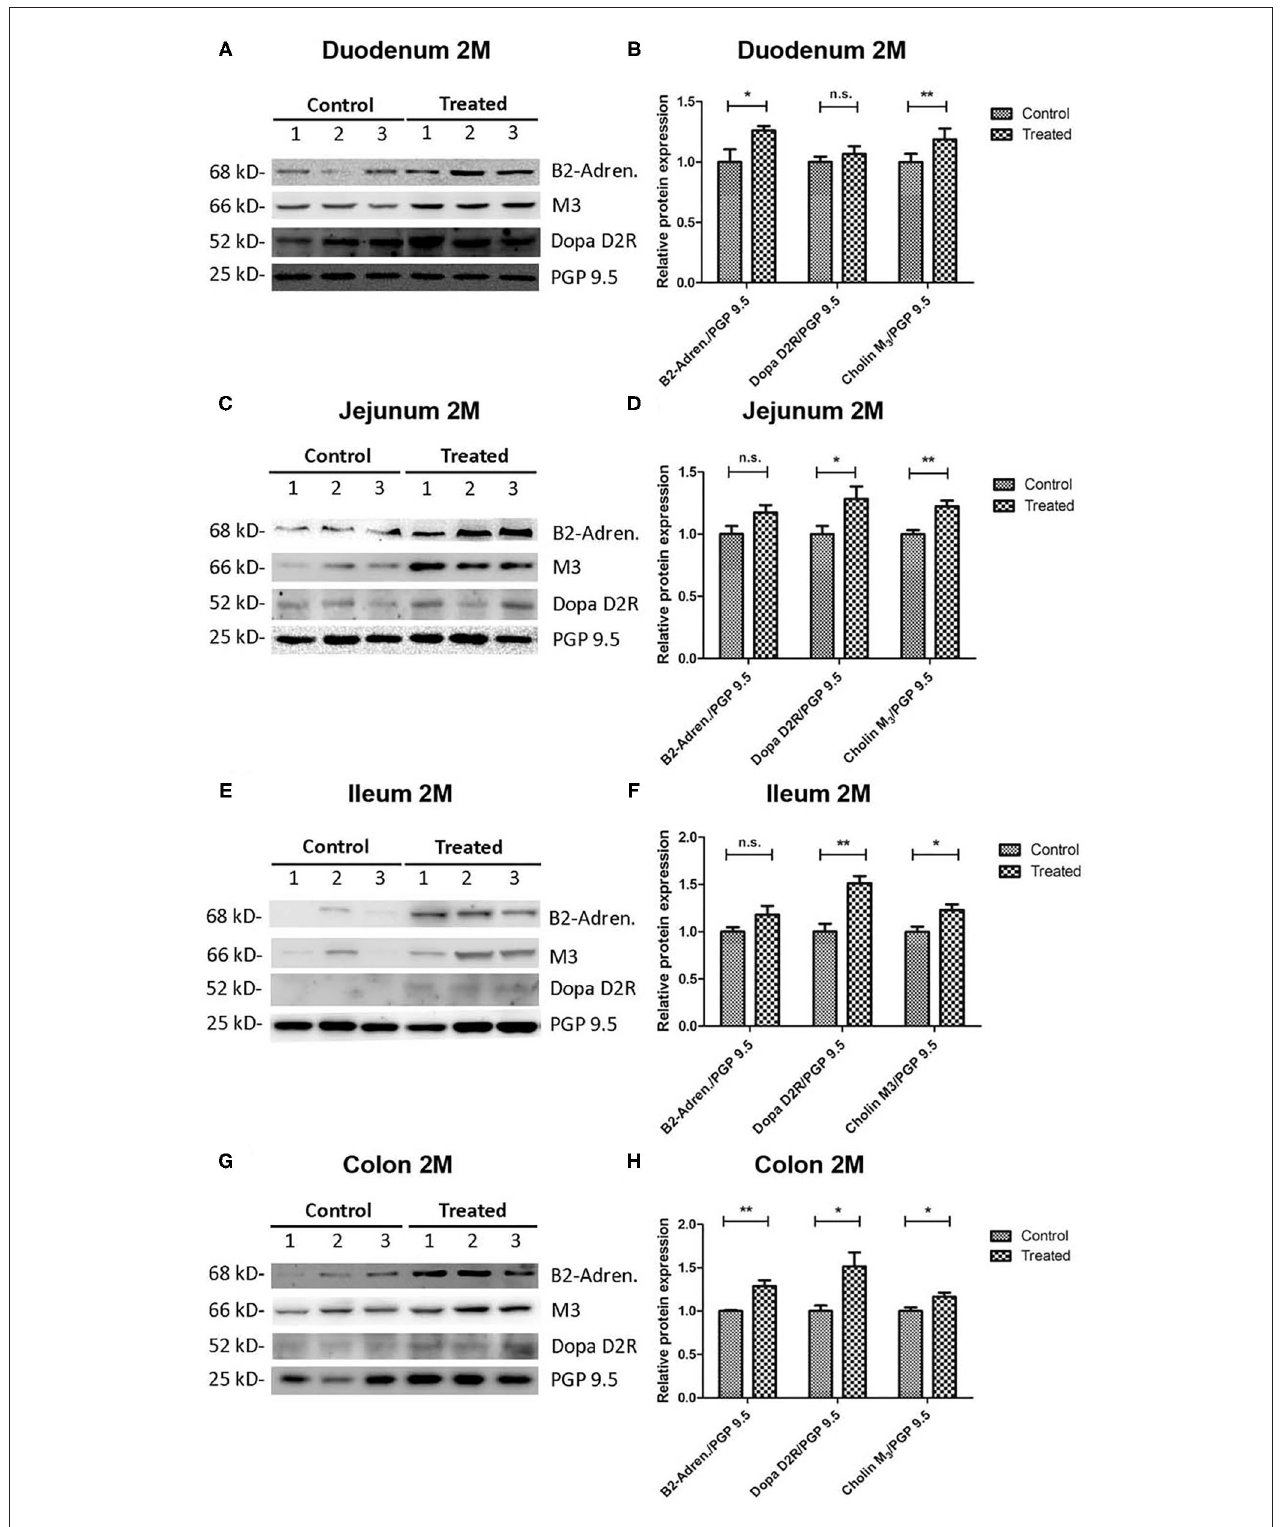
FIGURE 9 | Two-Month rotenone exposure induces an up regulation of the adrenergic (ß2-subunit), cholinergic (M3-muscarinic), and dopaminergic (D2) receptors in the gut. Blots in (A,C,E,G) show 3 representative examples per exposure group for the protein levels of adrenergic (ß2-subunit) (B2-Adren.),